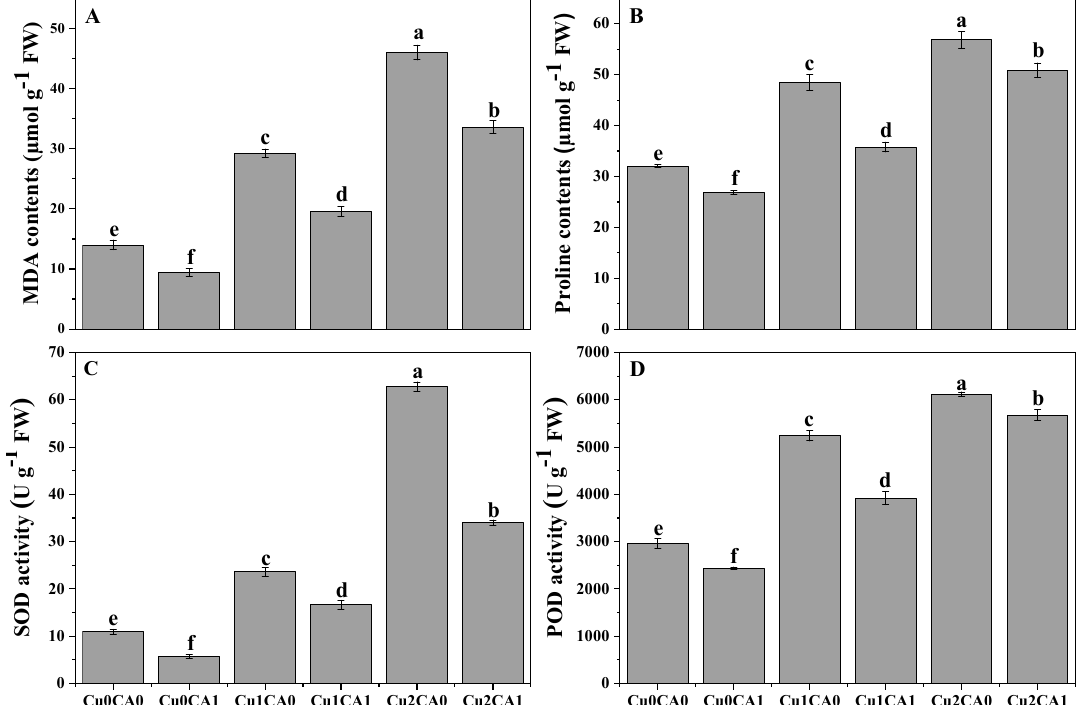
Figure 2. Effect of CA application on Cu-induced malondialdehyde (MDA) (A), proline contents (B), and antioxidative defense mechanisms such as activities of superoxide dismutase (SOD) (C) and peroxidase (POD) (D) in the leaves of C. capsularis seedlings grown under different stress levels of Cu. Values are demonstrated as means of three replicates along with standard deviation (SD; n =3). One- way ANOVA was performed and means differences were tested by LSD ( p < 0.05). Different lowercase letters on the error bars indicate significant difference between the treatments. Cu 0 CA 0 (Cu = 0 μ M and CA = 0 mM), Cu 0 CA 1 (Cu = 0 μ M and CA = 2 mM), Cu 1 CA 0 (Cu = 50 μ M and CA = 0 mM), Cu 1 CA 1 (Cu = 50 μ M and CA = 2 mM), Cu 2 CA 0 (Cu = 100 μ M and CA = 0 mM), Cu 2 CA 1 (Cu = 100 μ M and CA = 2 mM).